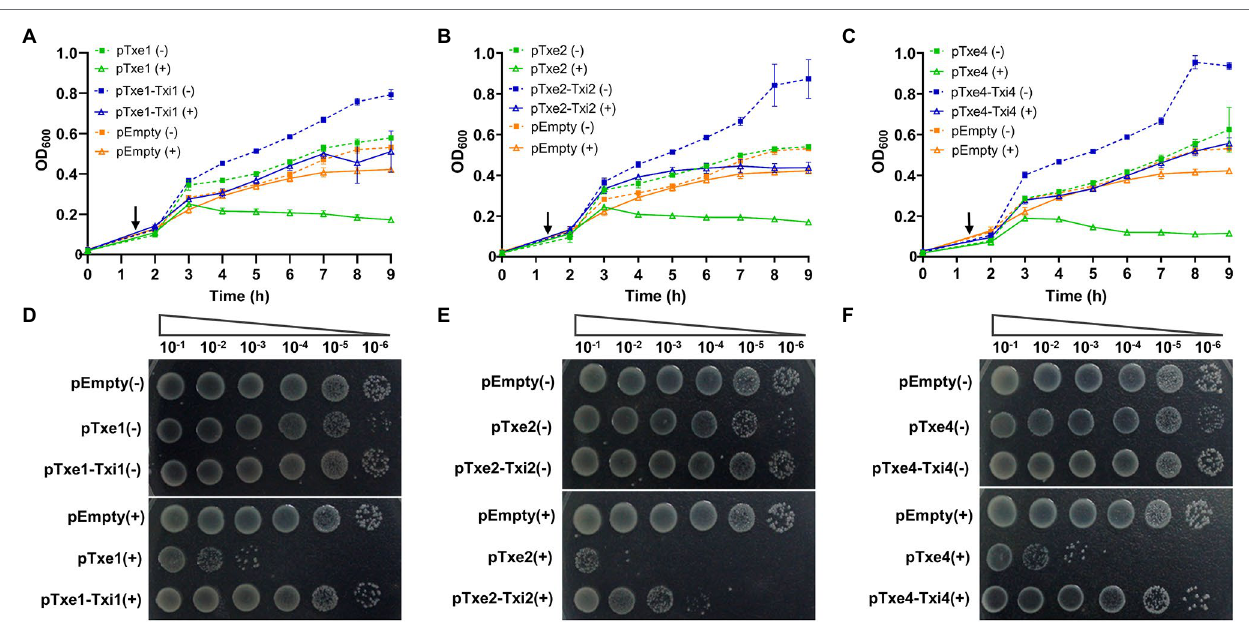
FIGURE 5 | Txe1-Txei1, Txe2-Txei2, and Txe4-Txei4 are three effector–immunity pairs. Growth curves of E. coli BL21(DE3) harboring indicated plasmids were obtained by measuring the OD 600 at 1-h intervals (A–C) . Data are presented as the mean ± SD of three independent experiments. Levels of survival of cells were compared by 10-fold serial dilution on LB medium containing arabinose or not (D–F) . The arrow indicates the time of induction with 0.2% L-arabinose, and (+) and ( − ) symbols indicate addition or not of L-arabinose, respectively. The experiment was repeated twice with similar results, and the results from a representative experiment are